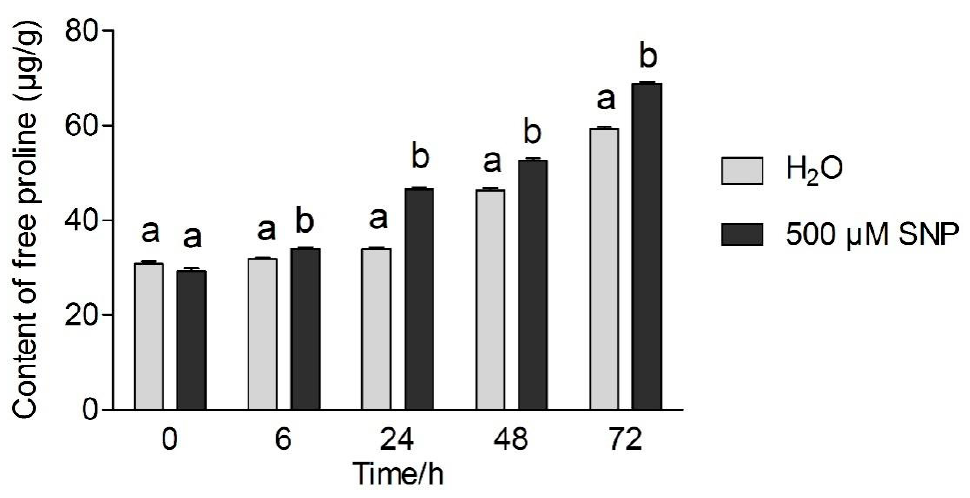
Figure 3. Effect of exogenous nitric oxide on proline content in tea leaves under cold stress.